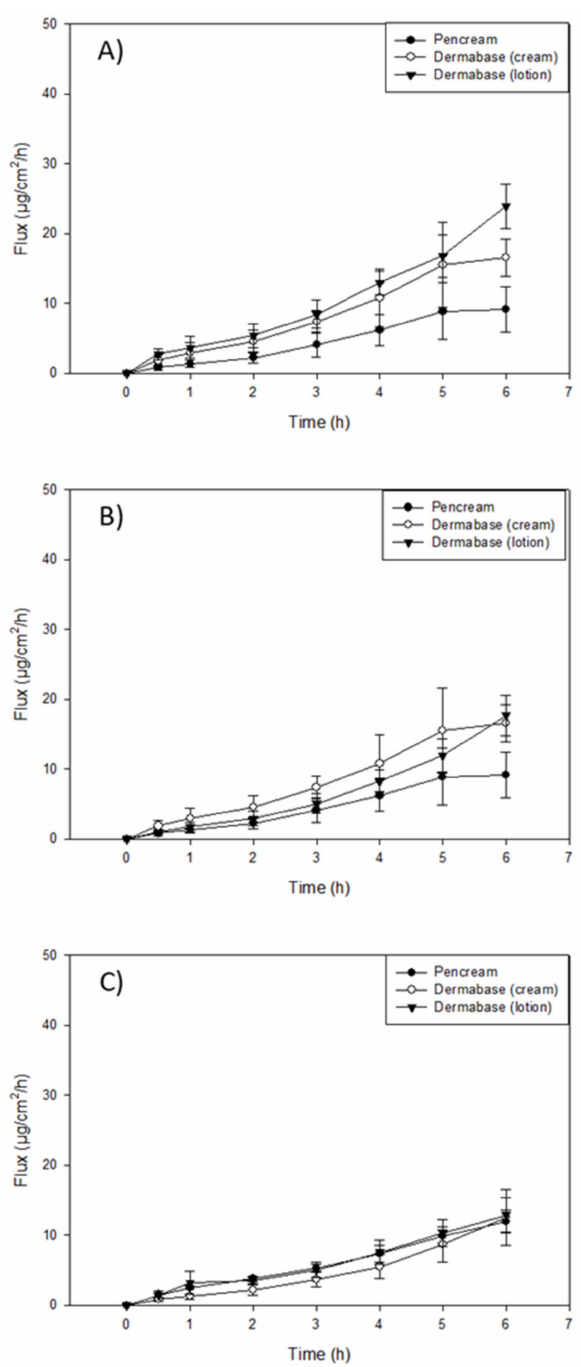
Figure 3. In vitro Franz cell/Strat-M ® permeation profile of resatorvid: ( A ) 5% creams and lotion formulations; ( B ) 2.5% creams and lotion formulations; and ( C ) 1.25% creams and lotion